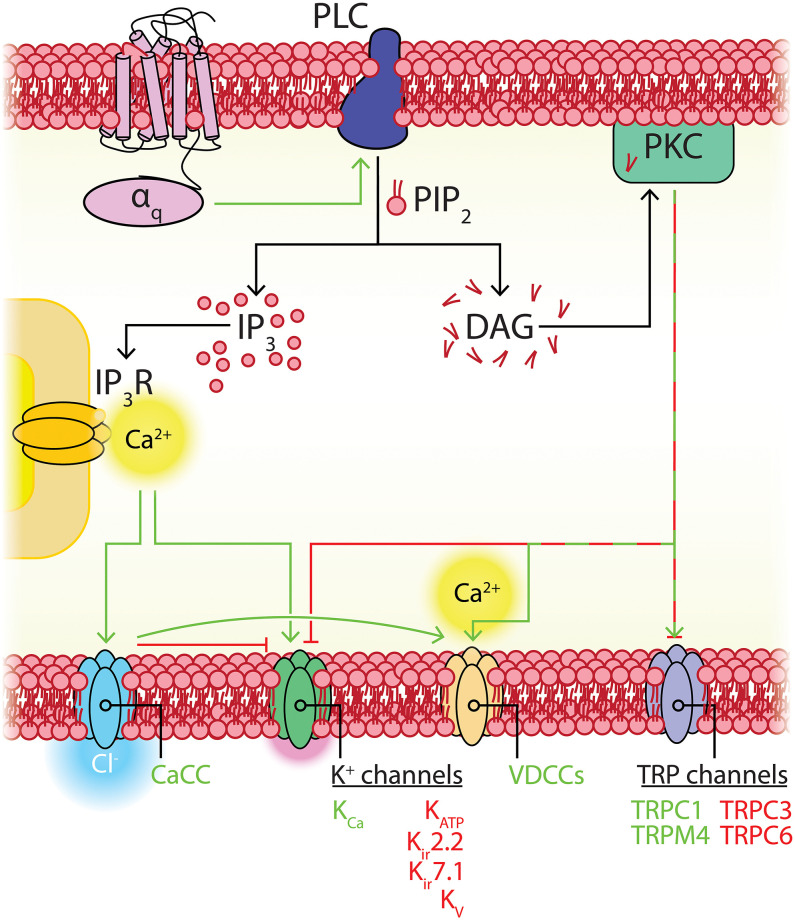
Potential GqPCR-ion channel interactions in capillary pericytes. GqPCR activation engages PLC, leading to the hydrolysis of PIP2 into IP3 and DAG. IP3 evokes Ca2+ release from the ER via resident IP3Rs, which may engage CaCCs and KCa channels. DAG stimulates PKC which has mixed effects on the TRP channels expressed by pericytes, promotes VDCC activity, and inhibits KATP, Kir, and Kv channels. The net effect of engagement of GqPCRs is thus membrane depolarization and intracellular Ca2+ elevation.